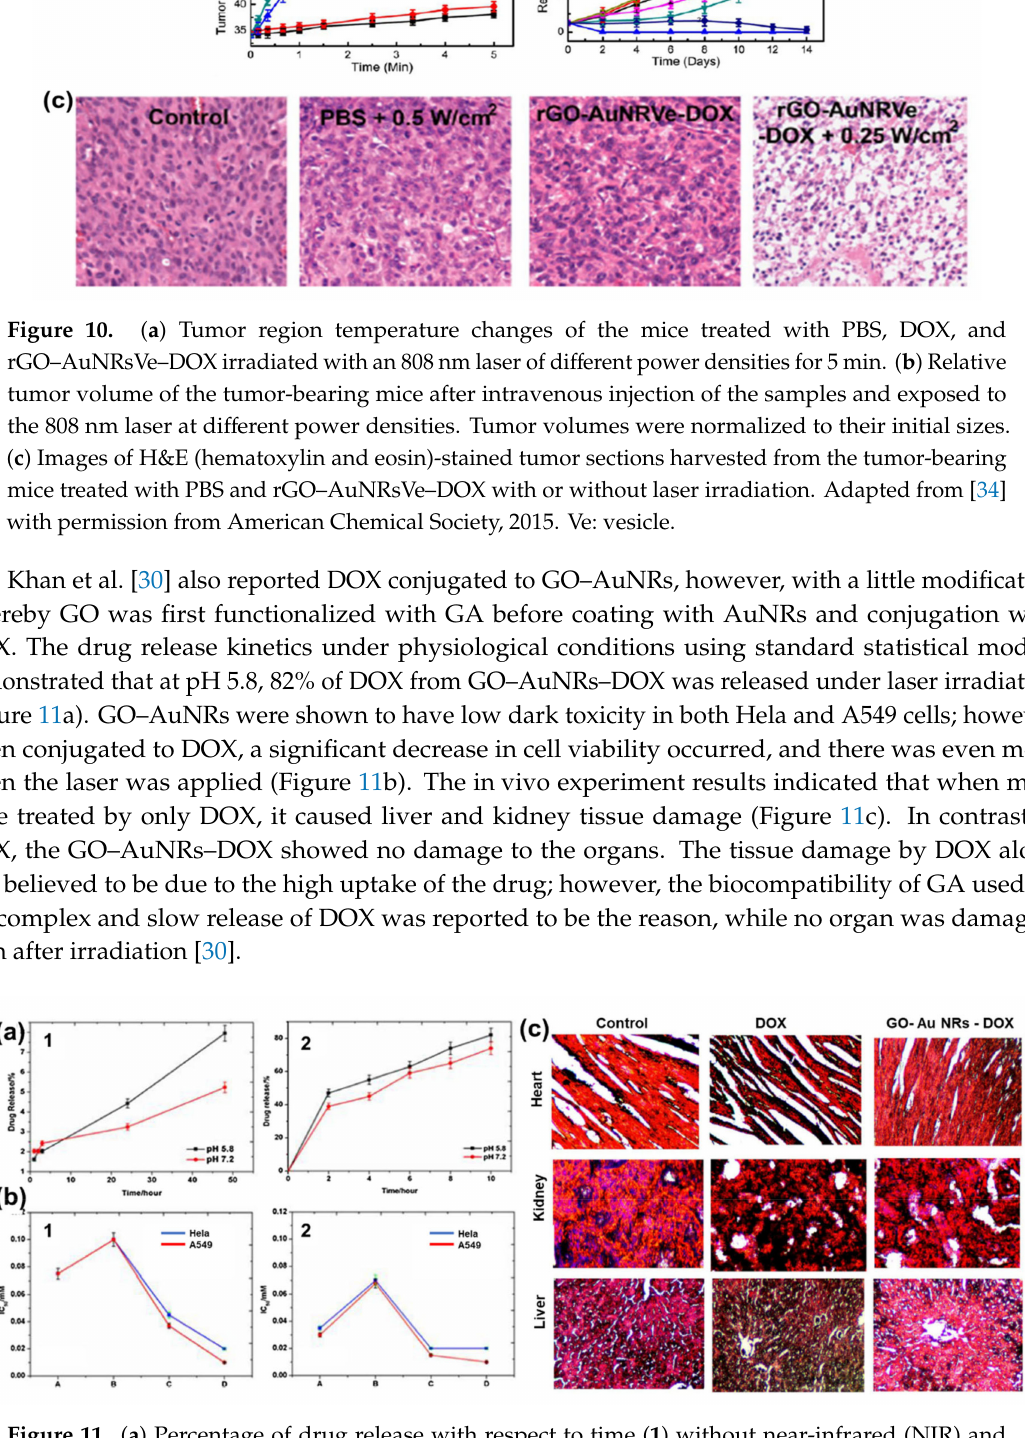
Figure 11. ( a ) Percentage of drug release with respect to time ( 1 ) without near-infrared (NIR) and ( 2 ) with NIR irradiation. ( b ) IC 50 values on in vitro cell lines ( 1 ) without NIR irradiation and ( 2 ) with NIR irradiation. ( c ) Histological images of a heart, kidney, and liver treated by DOX and fGO–AuNR–DOX Adapted from [30], with permission from Elsevier,